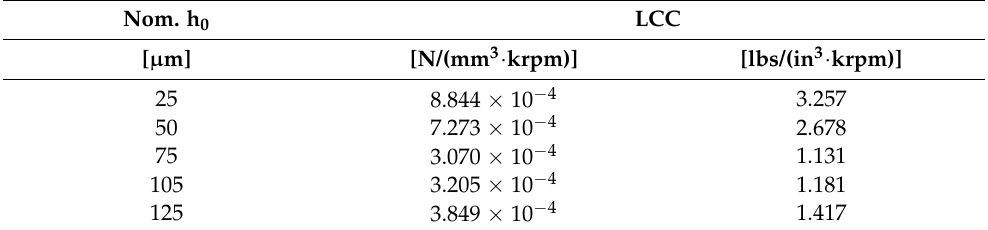
Table 3. Calculated load capacity coefficients (LCCs), for all bearing clearance configurations in SI-units as well as in the imperial unit system (for better literature